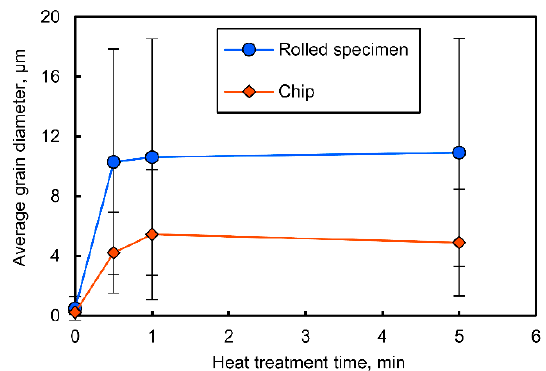
Figure 12. Variation of grain size in the chip and in the rolled specimen with heat treatment at 600 °C.